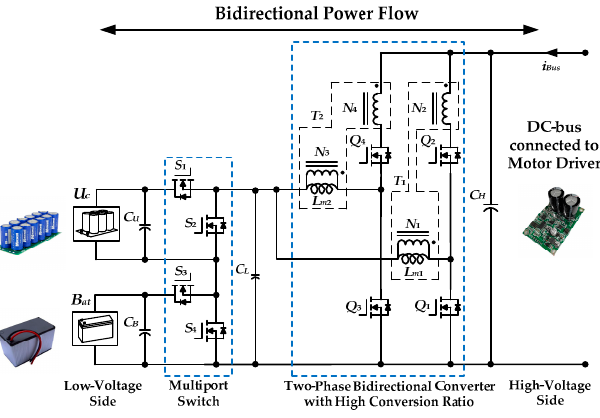
Figure 3. The proposed bidirectional power converter architecture.